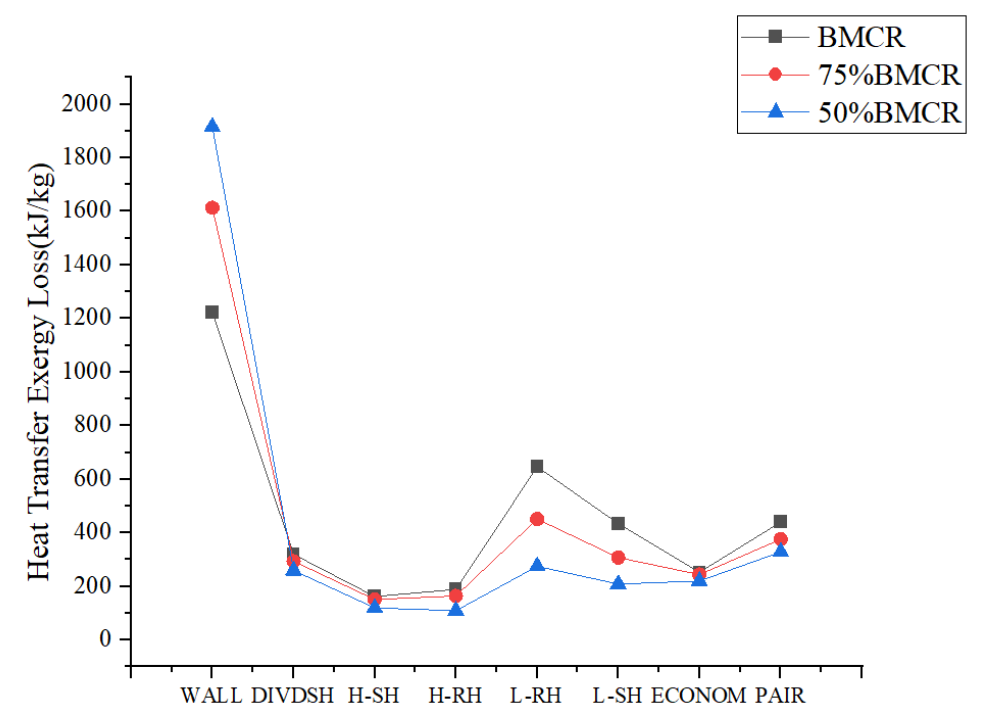
Figure 9. Variation of heat transfer exergy loss under different loads.